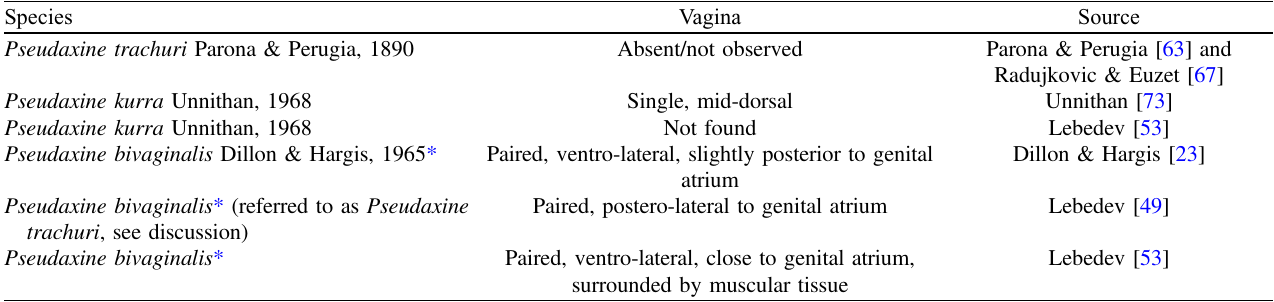
Table 5. Vaginal opening and its position in some species attributed to Pseudaxine